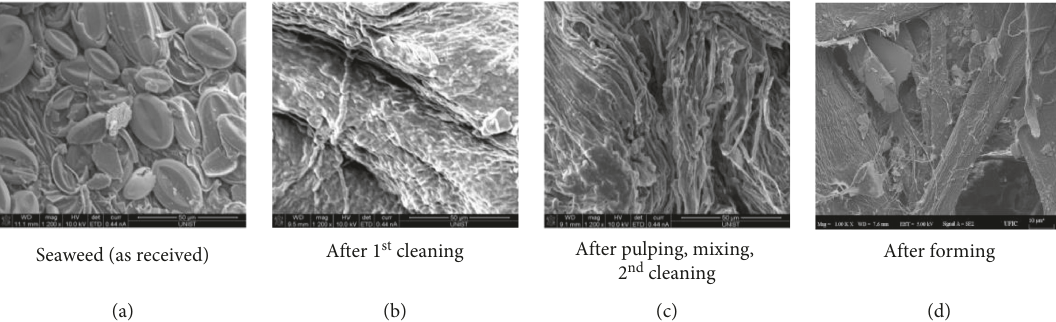
Figure 3: FE-SEM image of raw material (a seaweed: Gracilarialichenoides ): (a) as-received; (b) 1 st cleaned; (c) pulped, mixed, 2 nd cleaned; (d) formed into a sheet. The magnification rate is 1,000 for all images.